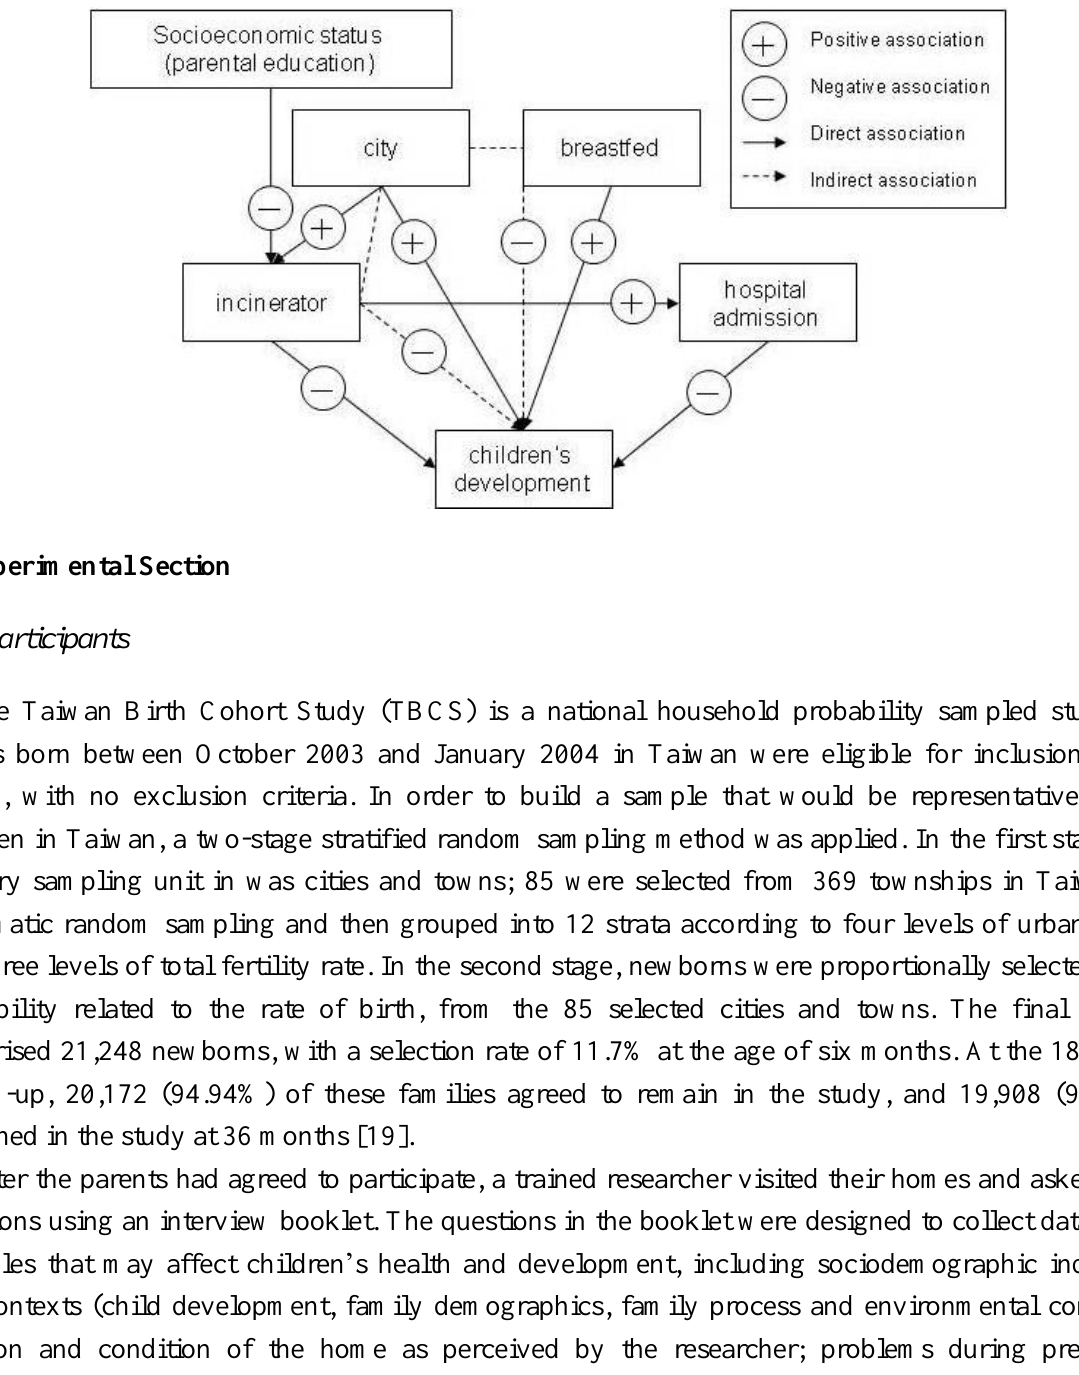
Figure 1. Hypothetical model of the pathway relationships among parental level of education, place of residence, living near an incinerator, breastfeeding, hospital admission, and child